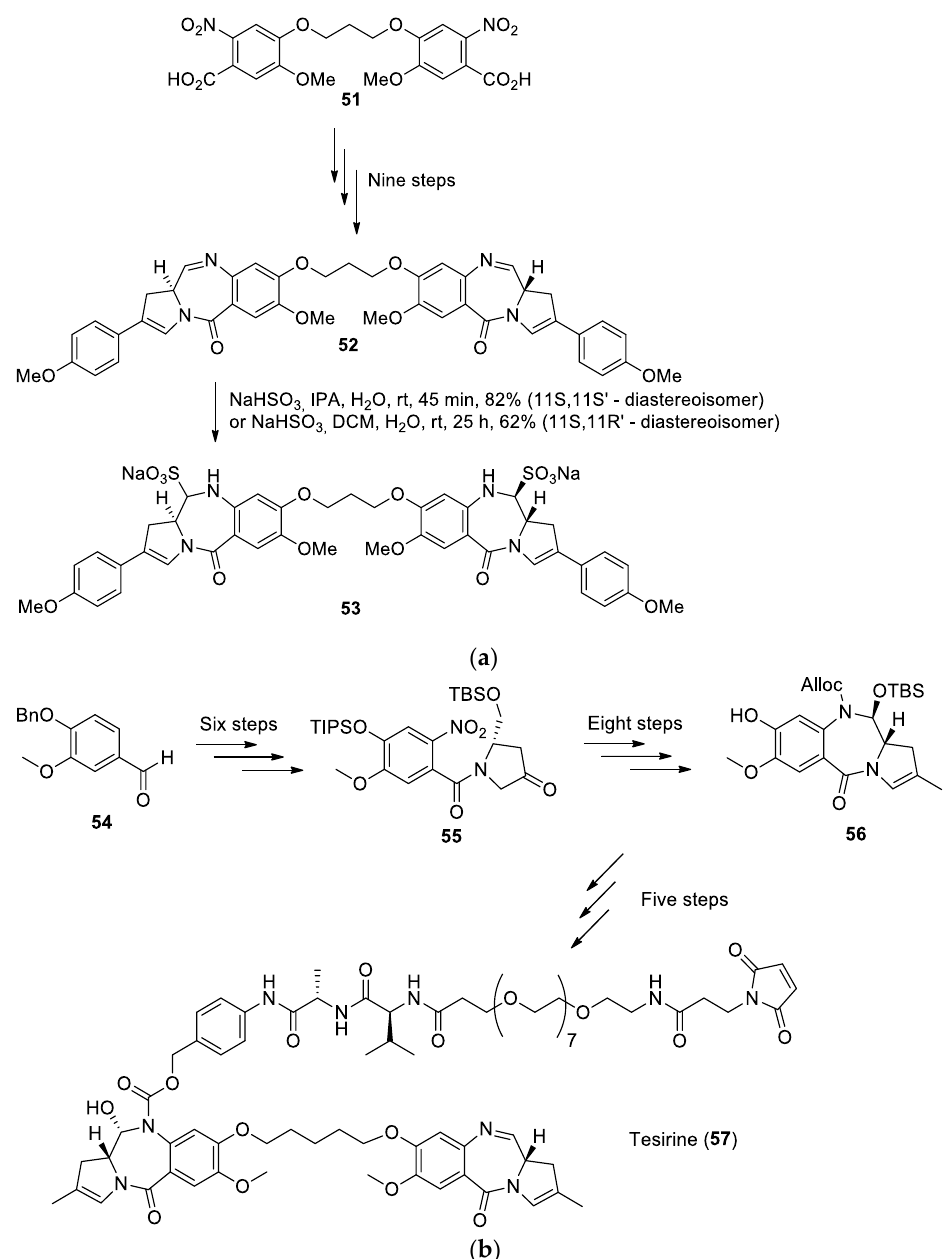
Figure 12. ( a ) SG2202 ( 52 ) and its prodrug SG2285 ( 53 ), two synthetic pyrrolo[2,1 − c][1,4]benzodiazepine (PBD) dimers synthesized from the 2-nitrobenzoic acid dimer ( 51 ). ( b ) Scale-up synthesis of Tesirine ( 57 ) starting from benzylvanillin ( 54 ).